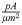
Ca2+ oscillation frequency and amplitude for different values of the volume ratio between the internal Ca2+ store and the intracellular space (ratioER), as well as the maximal pump currents of the Na+/Ca2+ exchanger (INCXmax) and the glutamate transporter (IGluTmax).The astrocytic compartment was stimulated for 200 seconds with a Poisson spike train of 100 Hz. a Ca2+ oscillation frequency for three different values of ratioER (0.08, 0.1 and 0.15), as a function of IGluTmax and INCXmax. The colored lines correspond to INCXmax equal to 0.0001pAμm2 (blue), 0.001pAμm2 (yellow), 0.01pAμm2 (gray), 0.1pAμm2 (green) and 1pAμm2 (red). The dashed line corresponds to IGluTmax equal to 0.68pAμm2. b Ca2+ oscillation frequencies for three different values of ratioER (0.08 0.1 and 0.15), as a function of IGluTmax and INCXmax. The colored symbols denote the values of INCXmax shown in a. c Ca2+ oscillation amplitudes for four different values of ratioER (0.05, 0.06, 0.1 and 0.15), and as a function of IGluTmax and INCXmax.